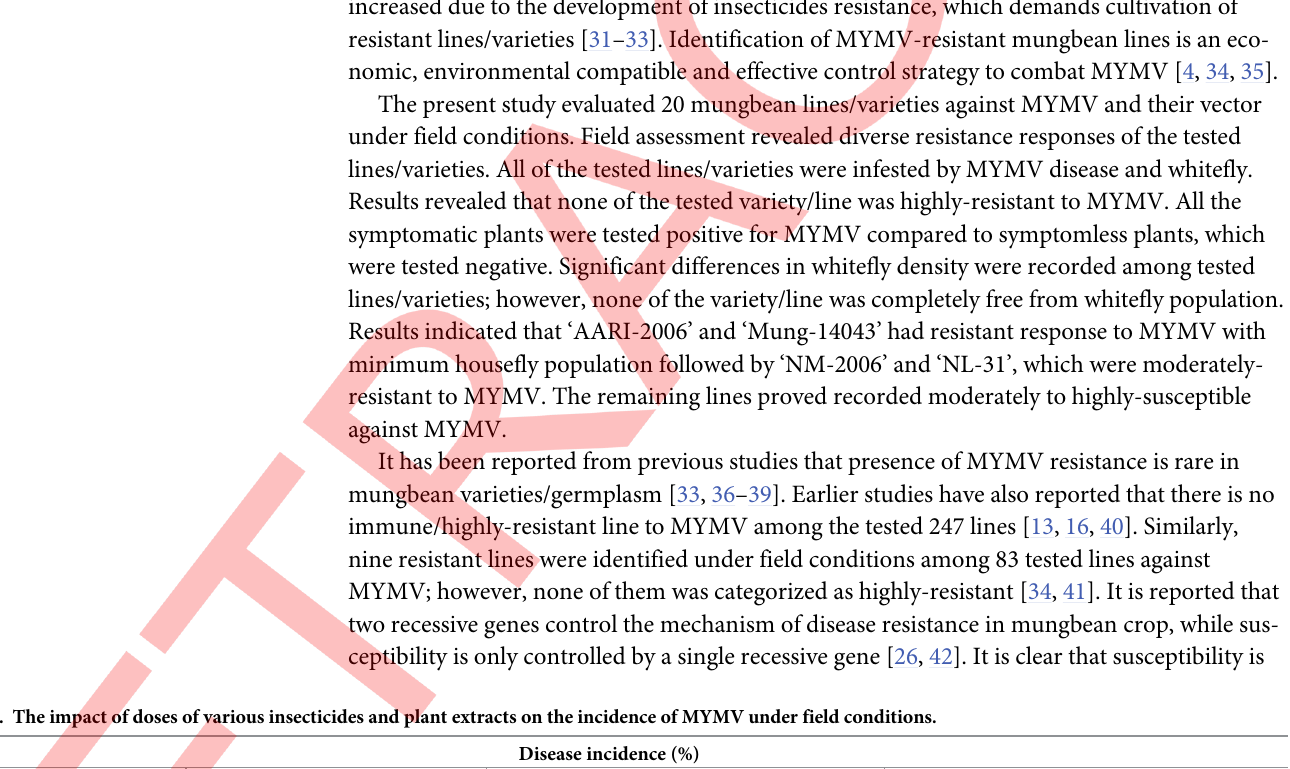
Disease incidence (%)